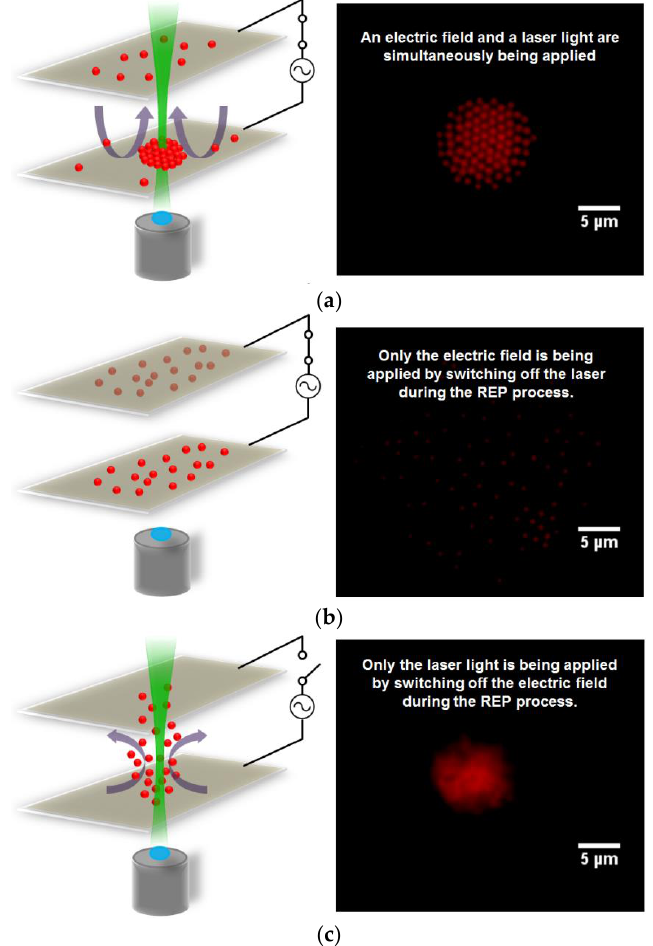
Figure 8. Hybrid features of REP. ( a ) Particle aggregation by the simultaneous application of a uniform AC electric field and a laser illumination. ( b ) Irregular distribution of particles on an electrode surface observed when turning off the applied laser only. ( c ) Convection of particles caused by turning off the applied electric field only. Reprinted/adapted by permission from (the RightsLink Permissions Springer Customer Service Centre GmbH): (Springer Nature) (Rapid Electrokinetic Patterning) by (Jae-Sung Kwon, Raviraj Thakur, Steven T. Wereley) (COPYRIGHT) (2012).